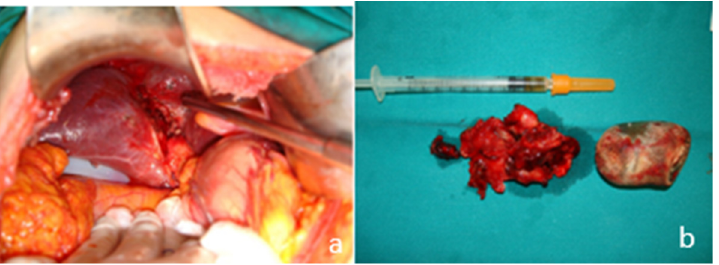
Figure 5. Intraoperative images. ( a ) Intrahepatic perforation of the gallbladder; ( b ) the resected gallbladder and the stone causing the neck obstruction. gallbladder and the stone causing the neck